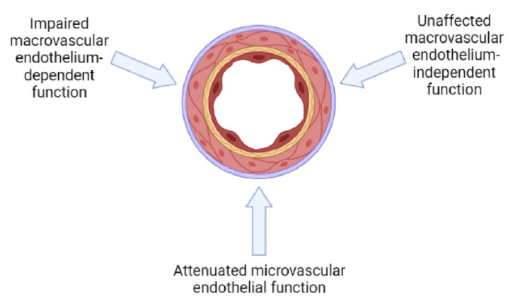
Figure 3. Endothelial function in patients with congenital